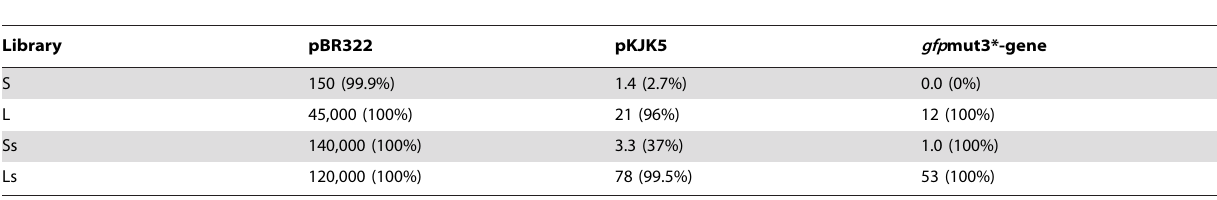
Table 2. Coverages a of model plasmids b from spiked and non-spiked wastewater metamobilomes.